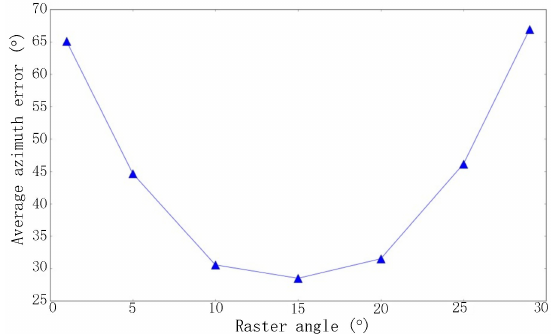
Figure 7. Average estimation error of azimuth in case of different setting of raster angles.